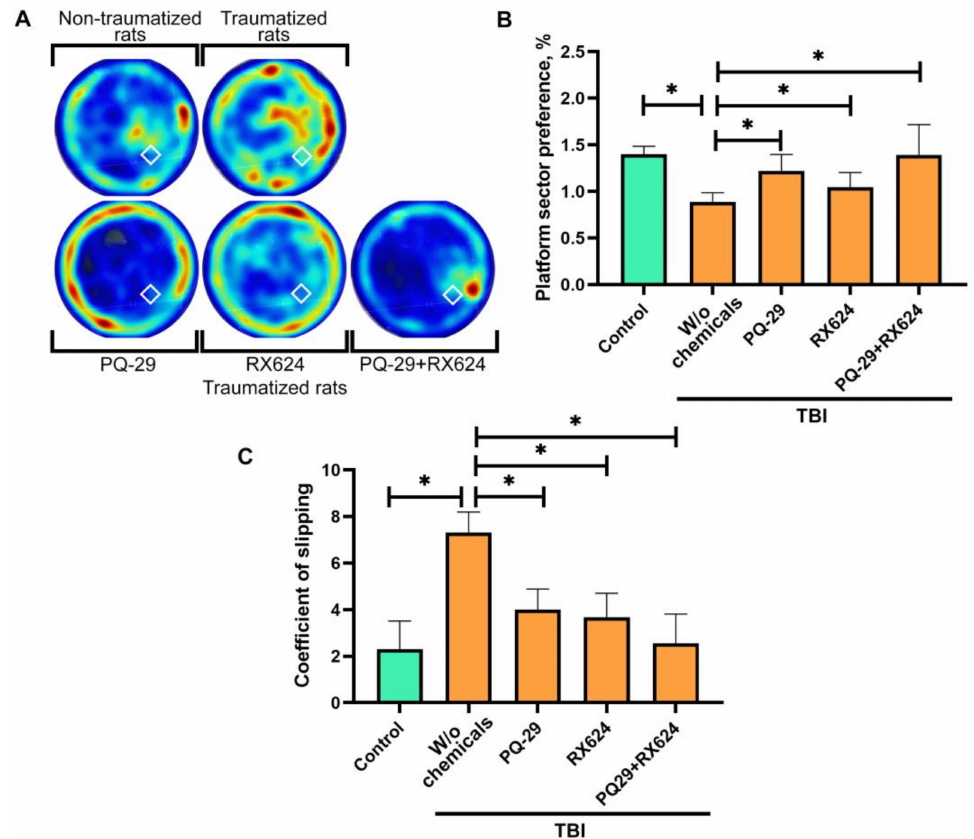
Figure 4. The results of the analysis of memory and motor function in traumatized rats after therapy with RX624 and PQ-29. The rats were divided into 5 groups: the control group (control), which contained naive animals, and 4 TBI groups containing traumatized animals that received intraperitoneal injections of drugs in accordance with the captions in the figure. ( A ) Memory function analysis was performed using the Morris water test. Heat maps of the movements of rats during the search for a platform are presented. The location of the escape platform during training is marked with a white square ( B ) The result of the analysis of the animals’ strategy used to find the platform in the Morris test is presented. The bar chart illustrates the ratio of the time spent by animals in the target sector to the average time spent in other sectors. ( C ) The state of the motor function of the animals was analyzed using the beam-walking test. Based on the results obtained, the slip coefficient was determined; the results are presented in the form of a bar chart. The mean values ± standard deviations are presented; differences are significant at * p < 0.05 (Mann—Whitney